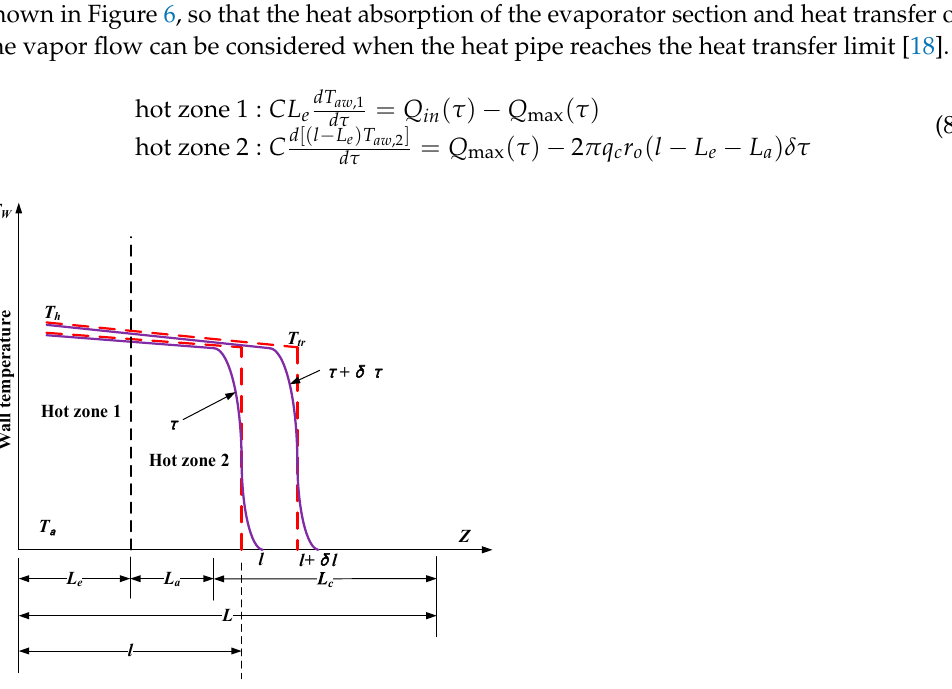
Figure 6. Improved plane-front model considering the heat transfer limit of the heat pipe.